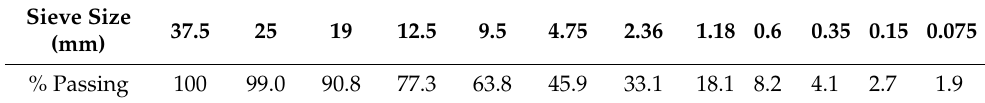
Table 2. Aggregate gradation of CIR